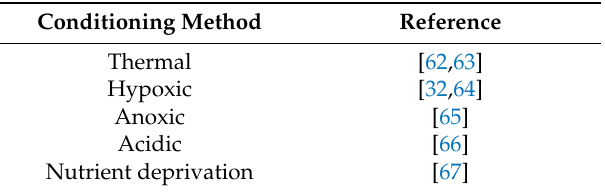
Table 1. Methods of physical and environmental cell